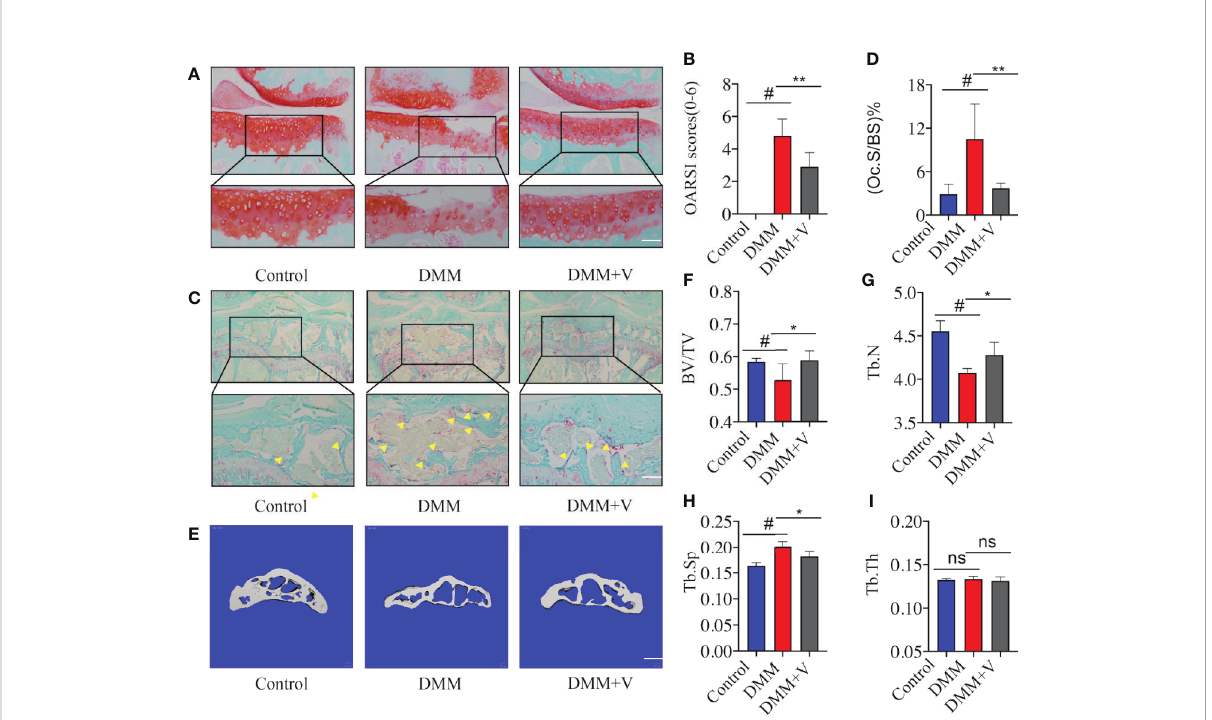
FIGURE 2 Velutin treatment reduces articular cartilage degeneration and subchondral bone deterioration in mice with DMM-induced OA. (A) Representative Safranin O staining of articular cartilage in distinct experimental groups; scale bar: 100 m m. (B) Osteoarthritis Research Society International (OARSI) scores of the cartilage. (C, D) Representative photos of fast green-stained subchondral bones and TRAP-stained osteoclasts in subchondral bone of the knee joint; the yellow triangle represents osteoclasts; scale bar: 100 m m. (E-I) Three-dimensional micro- CT images of the medial compartment of the tibial subchondral bone in sagittal views (control, DMM, and DMM+velutin groups); scale bar: 100 m m. Three-dimensional structural characteristics of the tibial subchondral bone histogram: (BV/TV) trabecular bone volume/tissue volume, (Tb.N) trabecular number, (Tb. Th) trabecular thickness, (Tb.Sp) trabecular separation, and trabecular bone volume/tissue volume, (Tb. Th) trabecular thickness. Data are presented as mean ± SD; # P < 0.01, * P < 0.05, ** P < 0.01, *** P <